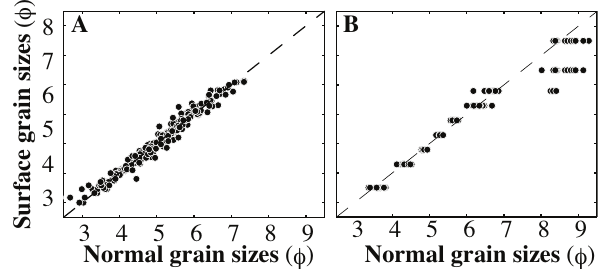
Fig. 4. Q-Q plots used to assess the accuracy of the normal fit of the φ -transformed grain-size distributions. (a) Comparison of the 10th, 20th, etc. quantiles of the 25 surface grain-size distributions to their equivalent normal distributions. (b) Comparison of the quantiles of the 15 surface-layer grain-size distributions to their equivalent nor- mal distributions. Plotted points are quite aligned on the x = y line, implying that all the φ -transformed samples can be fitted by a nor- mal